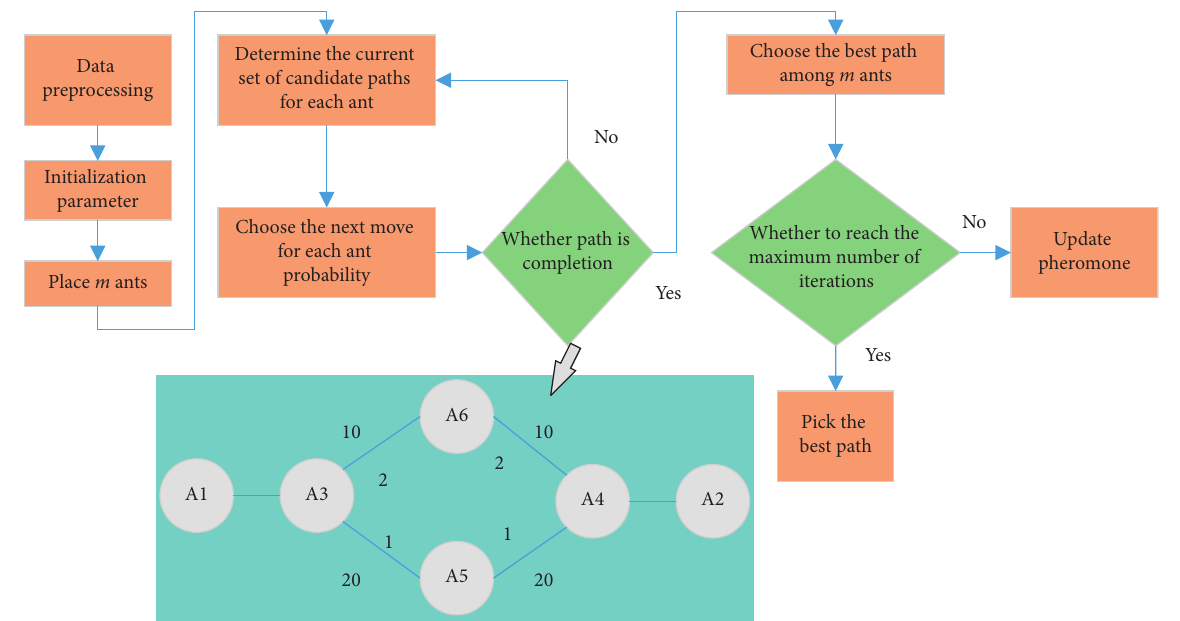
Figure 5: Schematic diagram of path